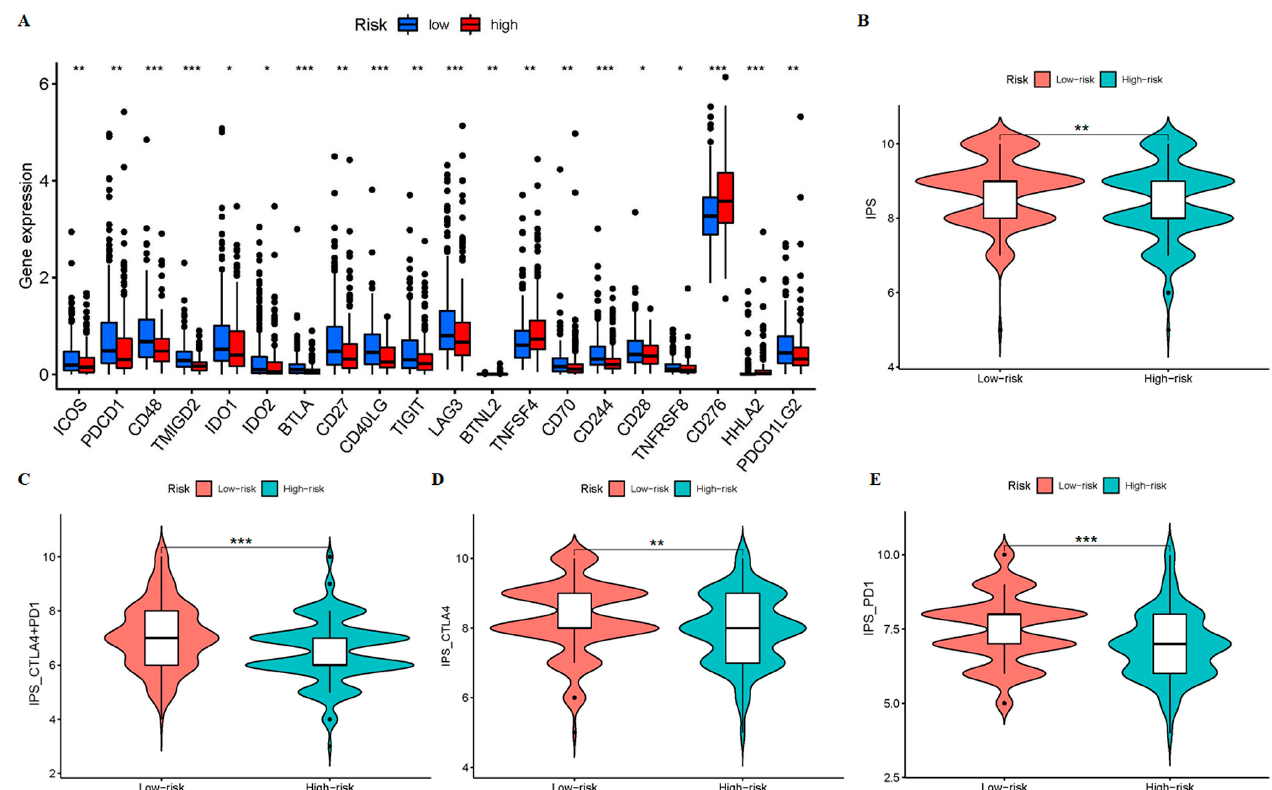
Figure 8. The comparison of the expressions of immune checkpoint genes and sensitivity to im- mune checkpoint inhibitors between high- and low-risk groups. ( A ) The boxplots for comparing the immune checkpoints genes between the two risk groups. The violin figures are for comparing the two risk groups of the treatment for using ( B ) none of CTLA4 or PD1, ( C ) CTLA4 + PD1, ( D ) CTLA4 alone, and ( E ) PD1 alone. * p < 0.05, ** p < 0.01, and *** p < 0.001.